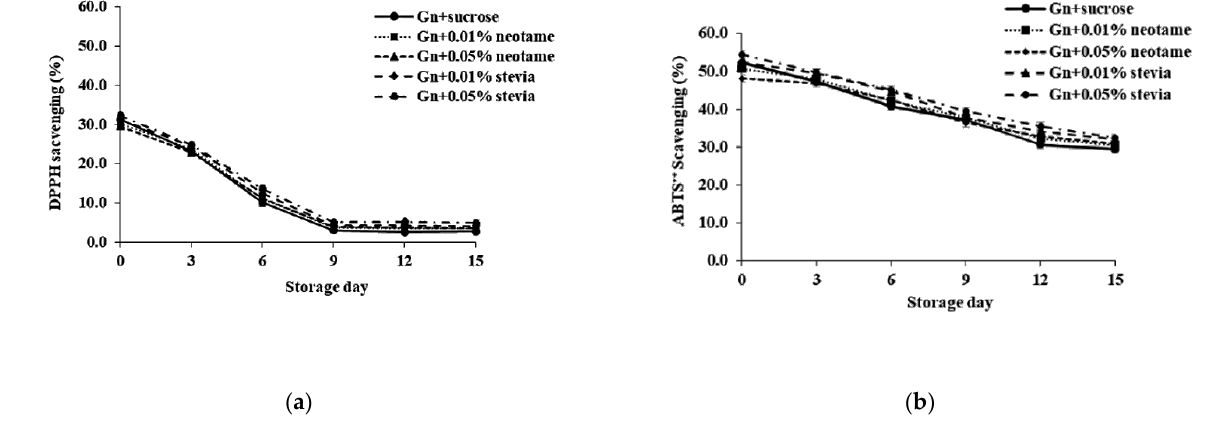
Figure 2. The radical scavenging activity of guava nectar (Gn) with sucrose and sweetened guava nectar during storage time at 5 °C by ( a ) ABTS •+ radical scavenging assay and ( b ) DPPH • radical scavenging assay.